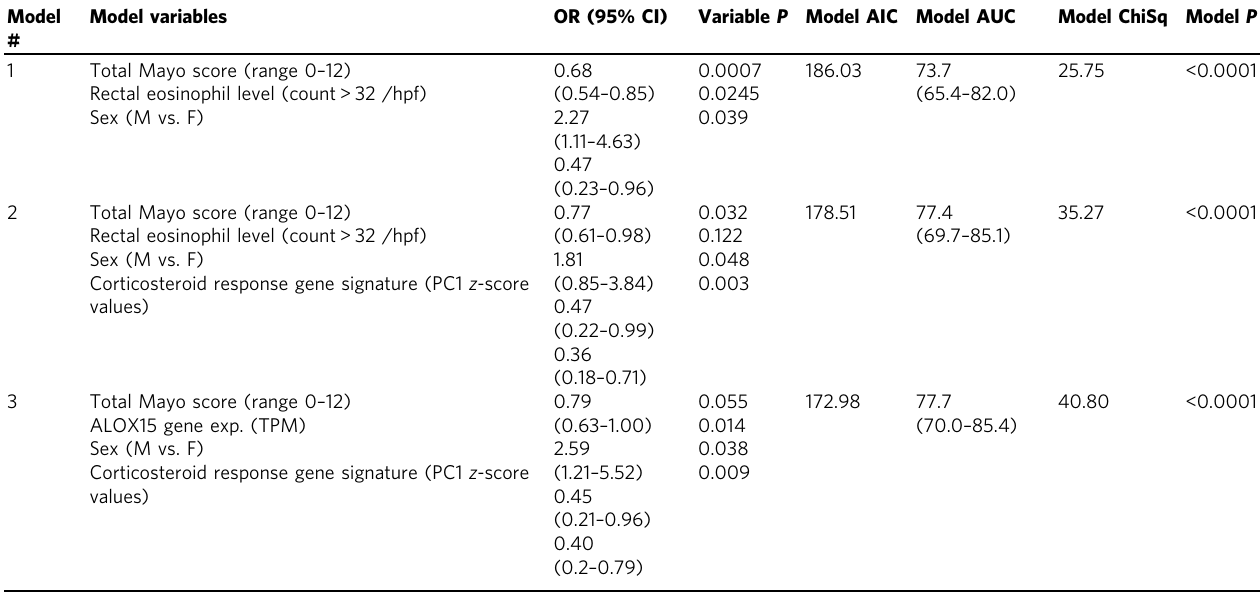
Table 2 Multivariable models of baseline characteristics and gene expression associated with week 4 remission in 147 patients with moderate-severe disease that received